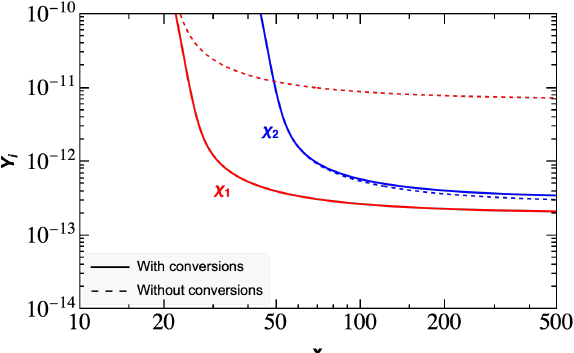
Figure 1 . Evolution of yields Y 1 , 2 (solid curves) as a function of x = m 1 /T with h σ ann , 2 v i = 6 × 10 − 9 GeV − 2 , h σ = 0 . 1 × 10 − 9 GeV − 2 , h σ = 4 × 10 − 9 GeV − 2 for m = 1000 GeV and ann , 1 v i conv , 12 v i 1 m 2 = 500 GeV . The dashed curves correspond to the case without conversions i.e. h σ conv , 12 v i = 0 . Notice that the freeze-out of χ happens at x = m 40 ⇒ m 20 . A similar result was 2 1 /T ’ 2 /T ’ obtained in ref.